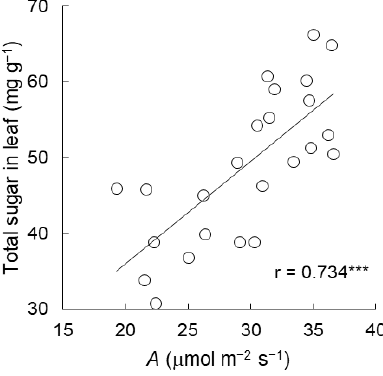
Figure 4. Relationship between A and total sugar concentration in leaf at 2 months after treatment in Exp. 1. The linear trendline and r value are shown in the graph. *** denotes significance at the 0.1% level.